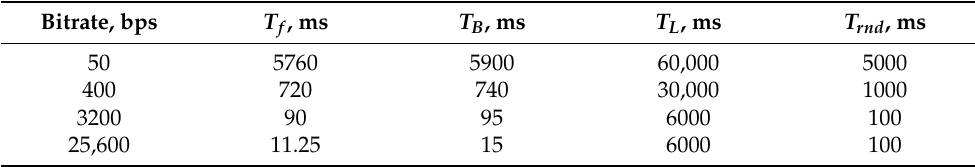
Table 3. Time interval values in